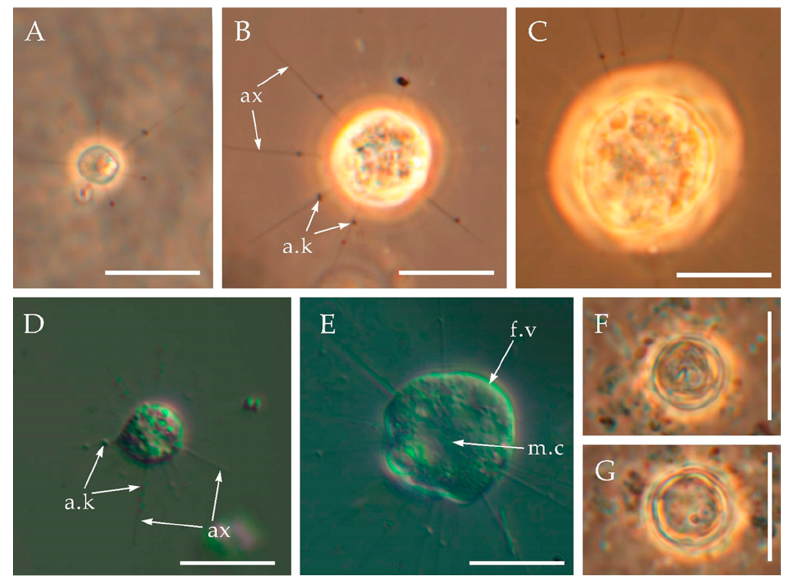
Figure 2. Triangulopteris lacunata gen. et sp. nov., strain HF-25 from the Kolyma Lowland after the loss of silica scales, light microscopy. ( A , D )—starving cells; ( B , C , E )—well-fed cells; ( F , G )—cysts. Abbreviations: a.k— axopodial kinetocysts; ax—axopodia; f.v—food vacuole; m.c—microtubule organizing center (MTOC). Scale bars: ( A – G )—10 µ m. Diversity 2021 , 13 , x FOR PEER REVIEW